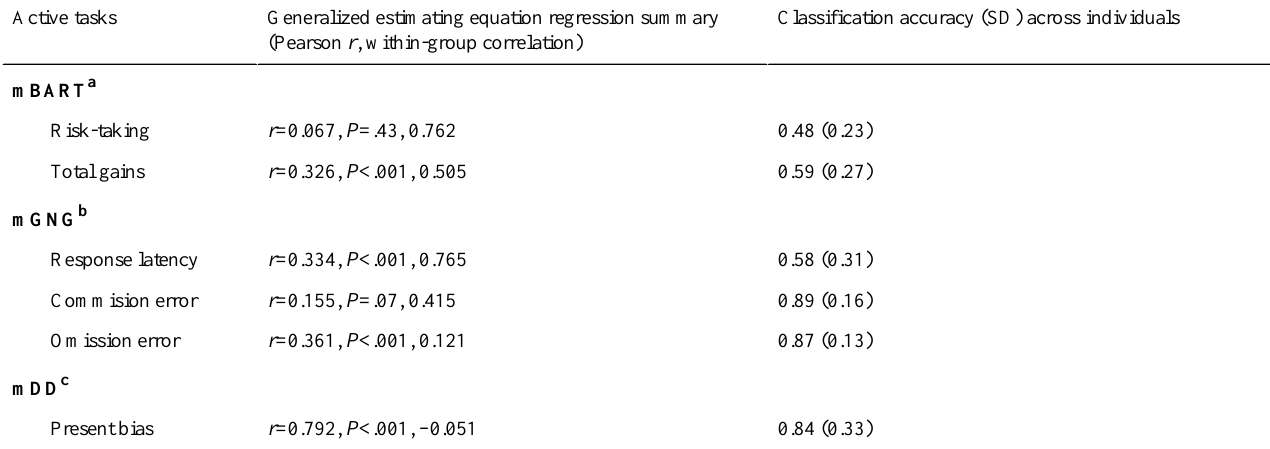
Table 5. Regression analysis and classification of mobile sensor data as predictors of daily active behavioral and cognitive